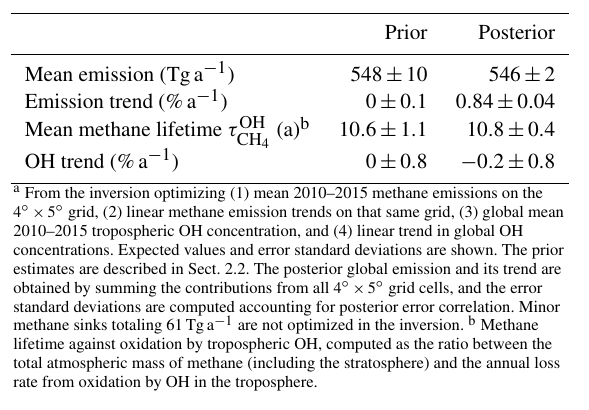
Table 2. Global 2010–2015 methane budget a .